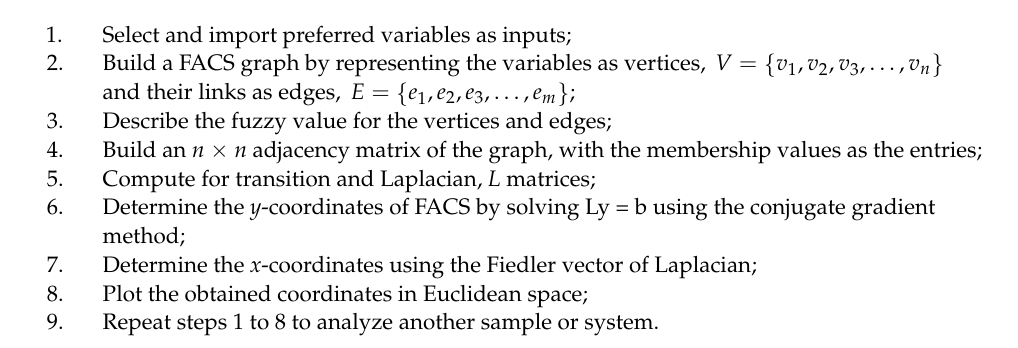
Algorithm 1 The coordinated c-FACS